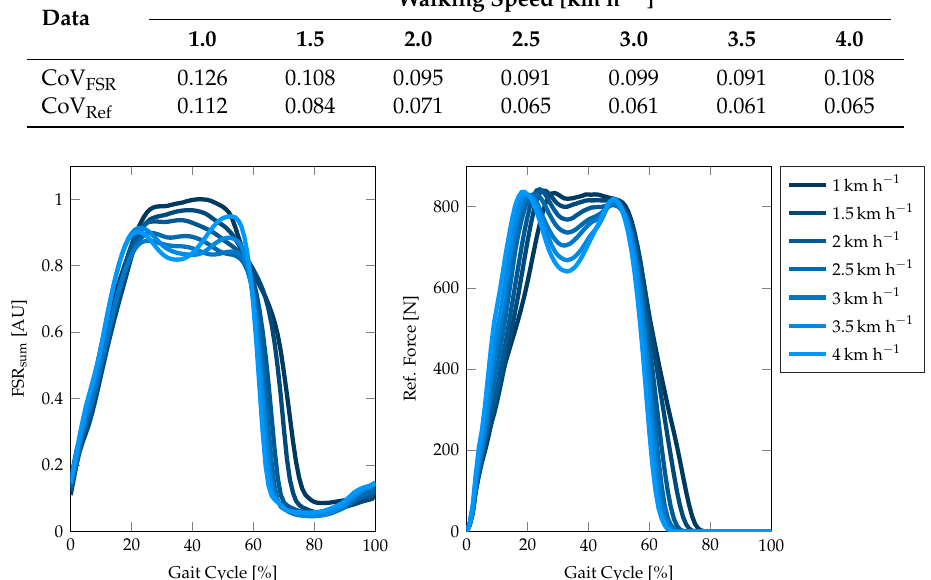
Figure 11. Exemplary comparison of the summed-up FSR signal and the force plate measurement during one walking trial of subject 1 from 1–4 kmh − 1 . The graphs show the mean morphology over all gait cycles at one particular speed. The gait cycles have been separated by the HS events detected by the proposed algorithm and the gait analysis software of the treadmill, respectively.